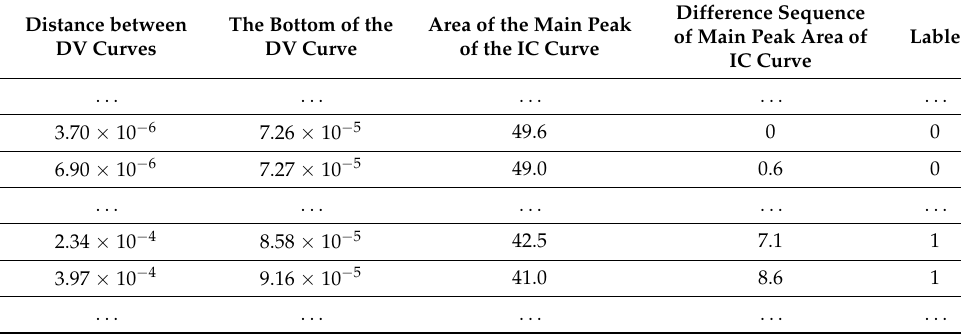
Difference Sequence of Main Peak Area of Lable IC Curve